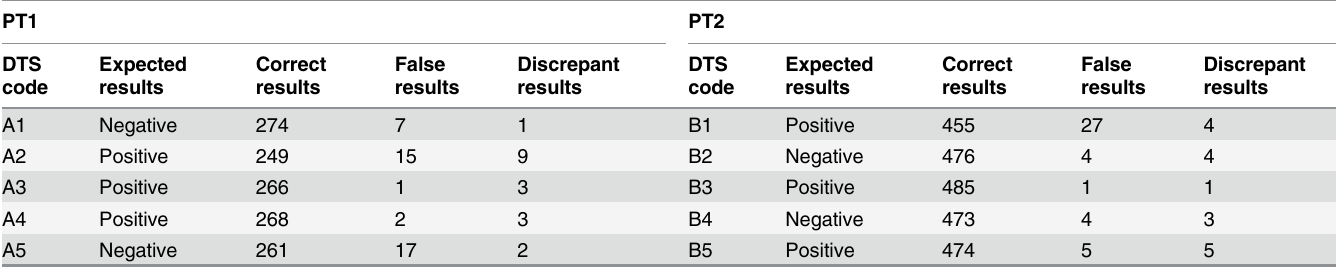
Table 3. Expected and reported results for each DTS specimen in PT1 and PT2.